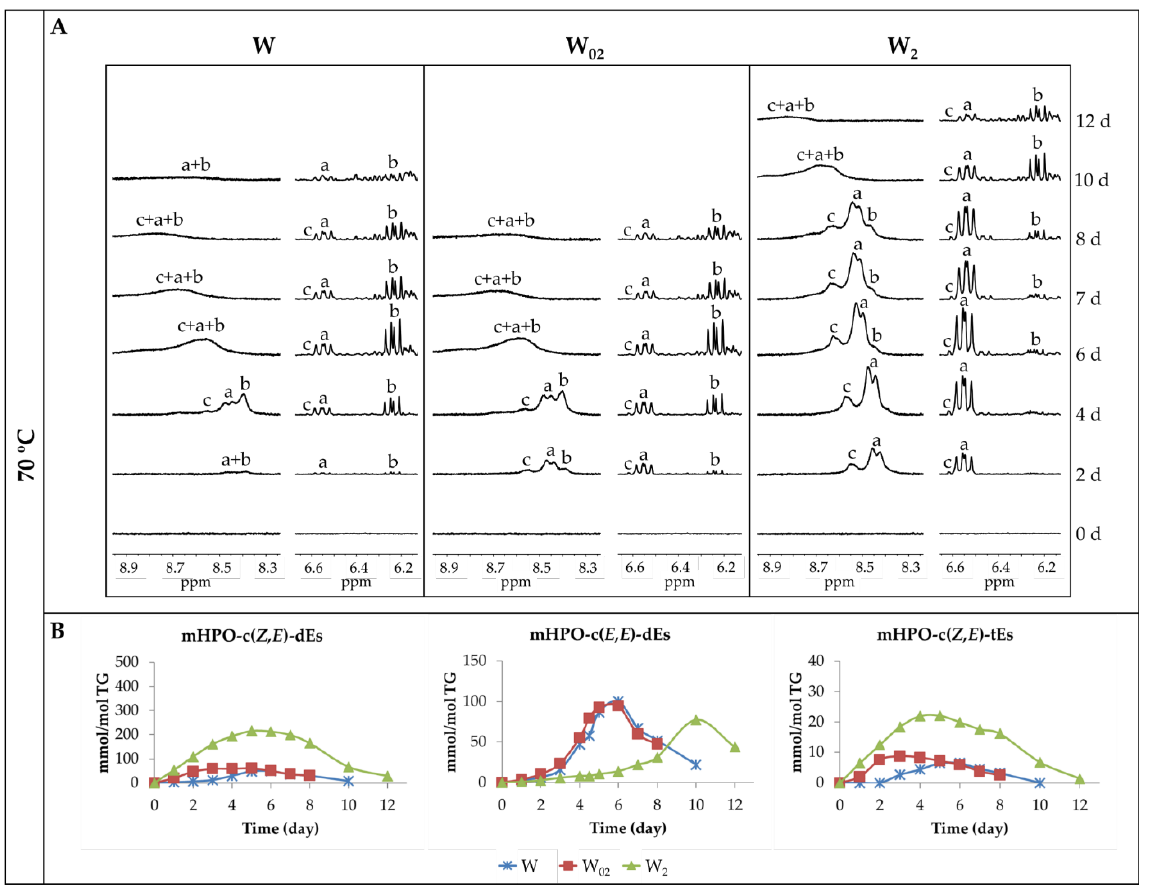
Figure 4. ( A ) 1 H NMR regions of the spectra of walnut oil samples with different αT enrichment degrees (W, W 02 and W 2 ), at different days (d) of their accelerated storage at 70 °C, in which signals of hydroperoxy protons in chains supporting conjugated dienic systems derived from linoleic and linolenic appear. Signals a and b are due to protons of mHPO-c( Z , E )-dEs and mHPO-c( E , E )-dEs respectively, derived from linoleic acyl group. Signals c are due to protons of mHPO-c( Z , E )-tEs derived from linolenic acyl group. ( B ) Evolution of the concentration of each kind of hydroperoxides throughout the storage up to advanced stages of the oxidation process.